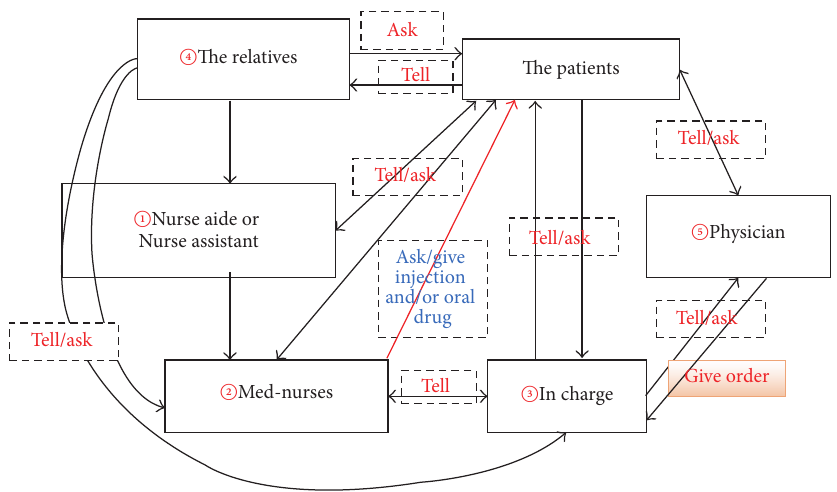
Figure 3: Illustration of the complex flow of